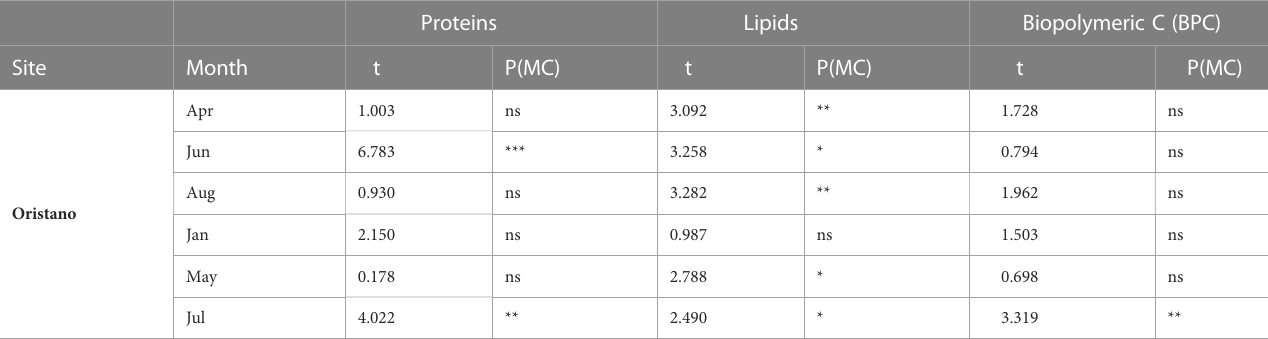
TABLE 2 Results of the pairwise comparisons contrasting proteins and lipid contents between sediment and feces in the meso-eutrophic site (Oristano) in all sampling dates.